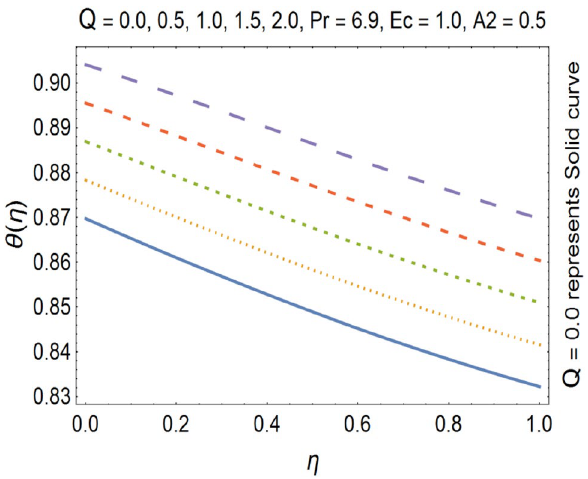
Figure 17. Temperature profile for various Q.